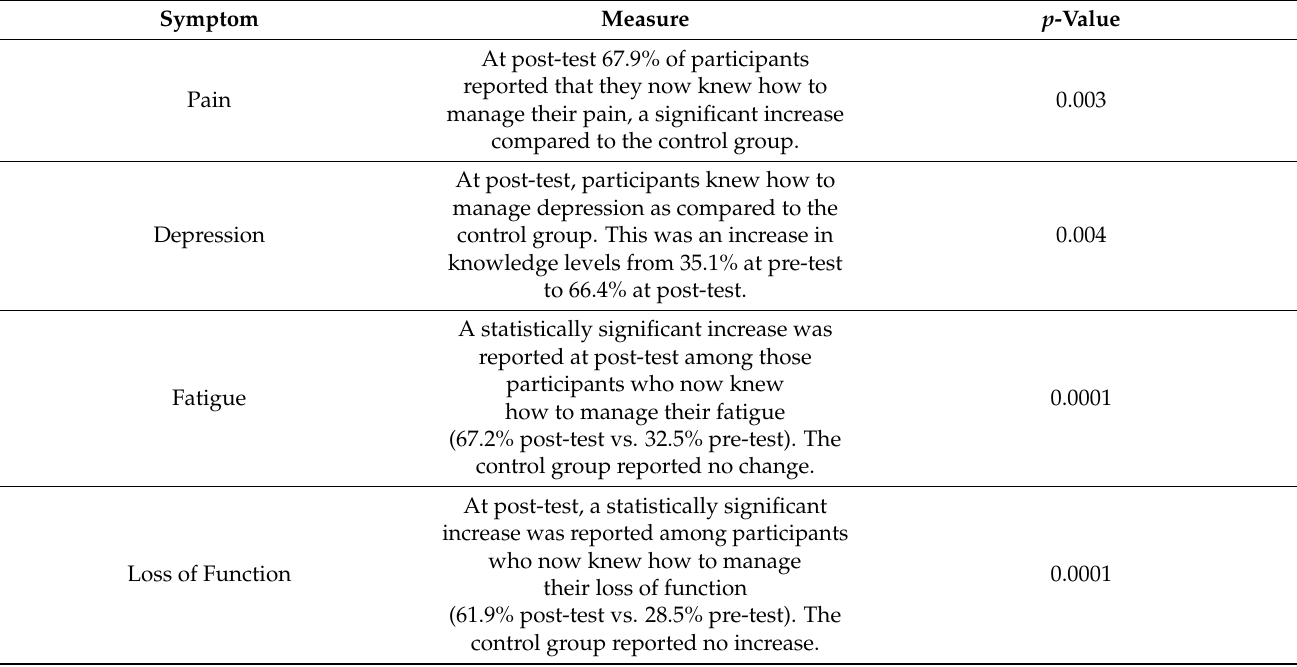
Table 2. Pre-test–Post-test knowledge